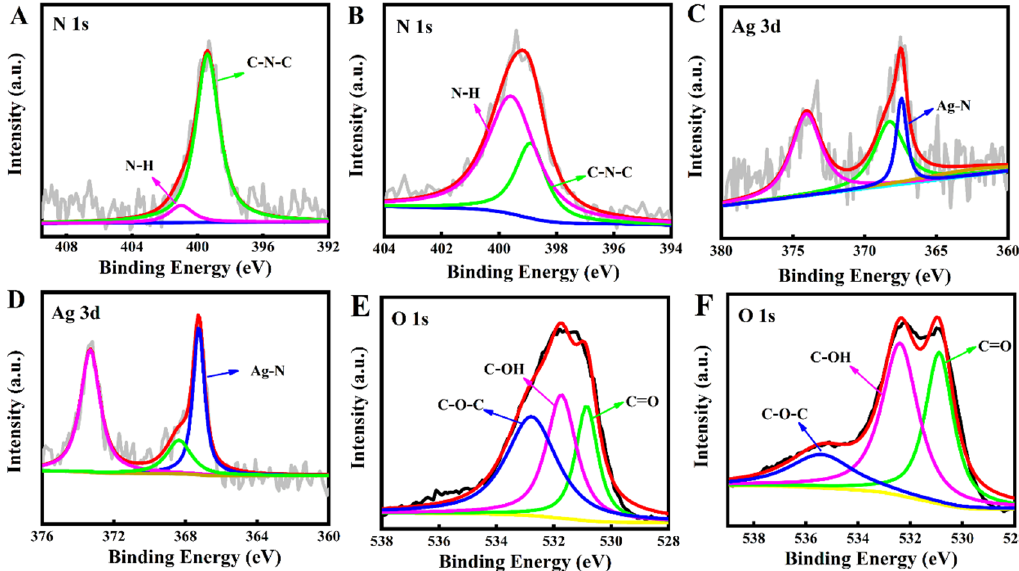
Figure 3. High-resolution XPS profiles: ( A ) N 1s for the AgNPs/N-CQDs composite, ( B ) N 1s for the AgNPs/N-CQDs composite, ( C ) Ag 3d for the AgNPs/N-CQDs composite, ( D ) Ag 3d for the AgNPs/N-CQDs composite, ( E ) O 1s for the AgNPs/N-CQDs composite, and ( F ) O 1s for the AgNPs/N-CQDs